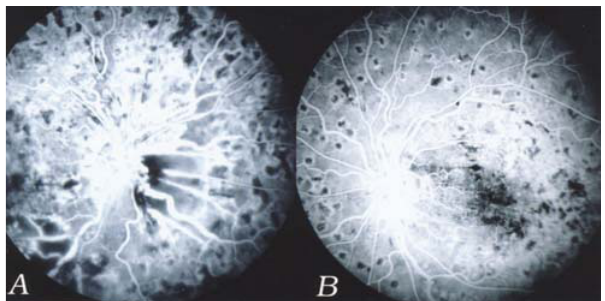
Figure 1 - Angiofluoresceinography of both eyes in September 2003. A – The right eye shows dilated veins alongside the background diabetic retinopathy. Laser marks and large areas of capillary nonperfusion are visible throughout the mid-peripheral retina. B – The left eye shows the diabetic background retinopathy and a less coarse laser